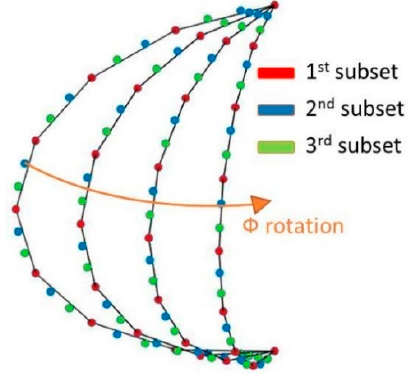
Figure 2. Sampling scheme and division in subsets, N = 3.